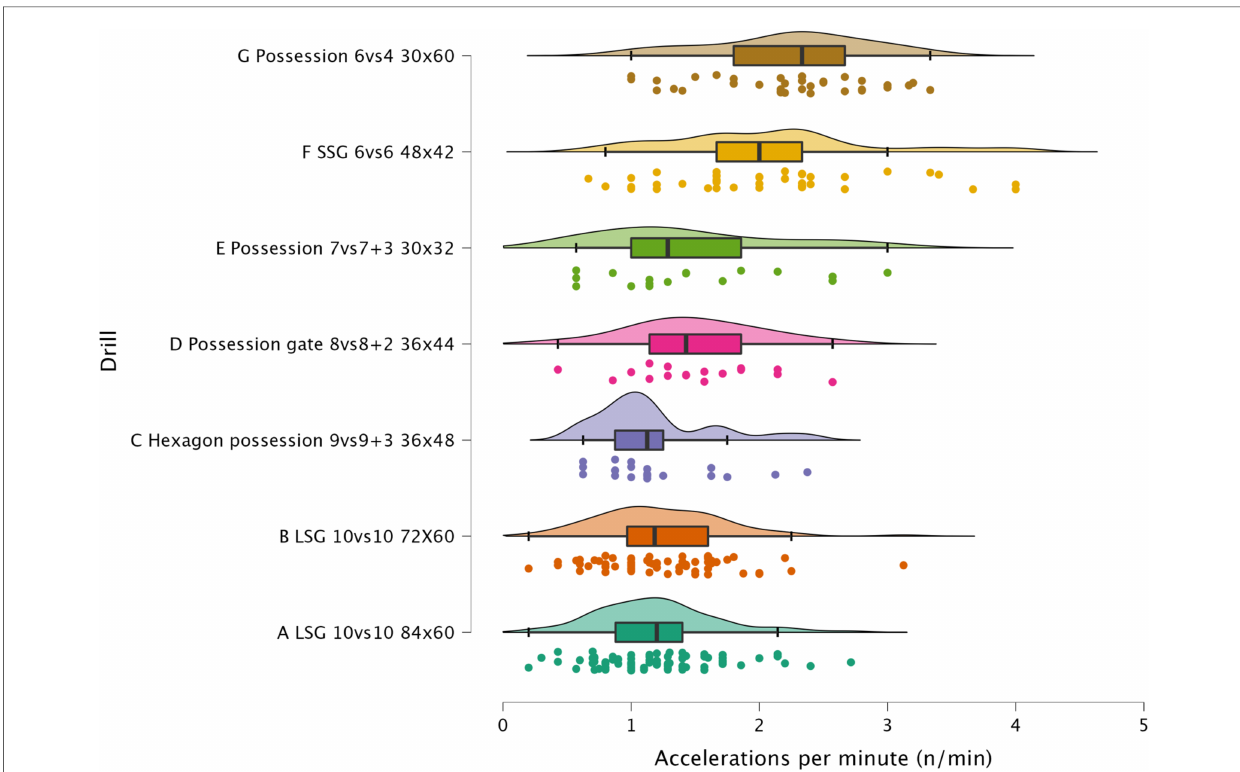
FIGURE 4 Comparison of accelerations per minute between drills. The data distributions show, mean, standard deviation, 95% con fi dence intervals, and individual data